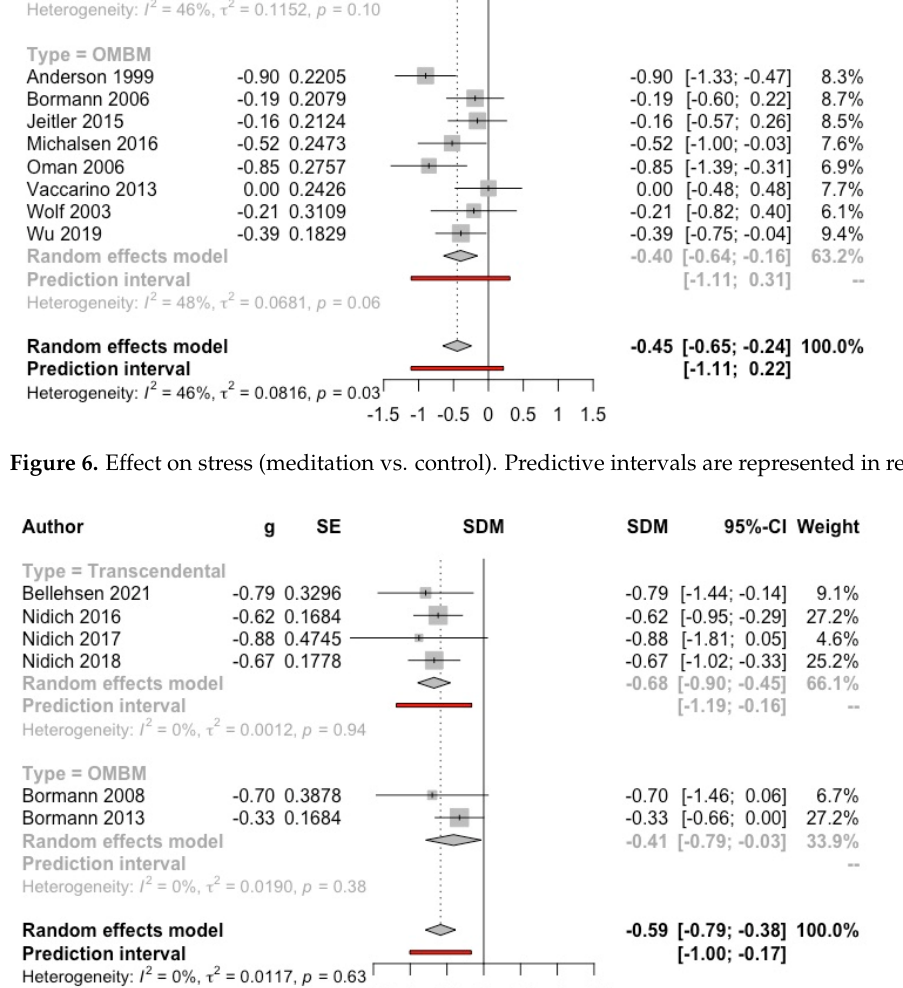
Figure 8. Effect on post-traumatic stress disorder symptoms (clinician-reported) (meditation vs. con- trol). Predictive intervals are represented in red. Meditation versus psychotherapy . Four studies ( n = 464) (one of them with two sub- samples) that used the PCL were included in the MA. Three studies applied TM [14,55,68] and two studies applied OMBM in veterans [15,68]. The result was significantly favoura- ble to the intervention (g = − 0.40, 95% CI: − 0.79, 0.00; I 2 = 27%; prediction interval: − 1.69, 0.89) (see Figure 9).